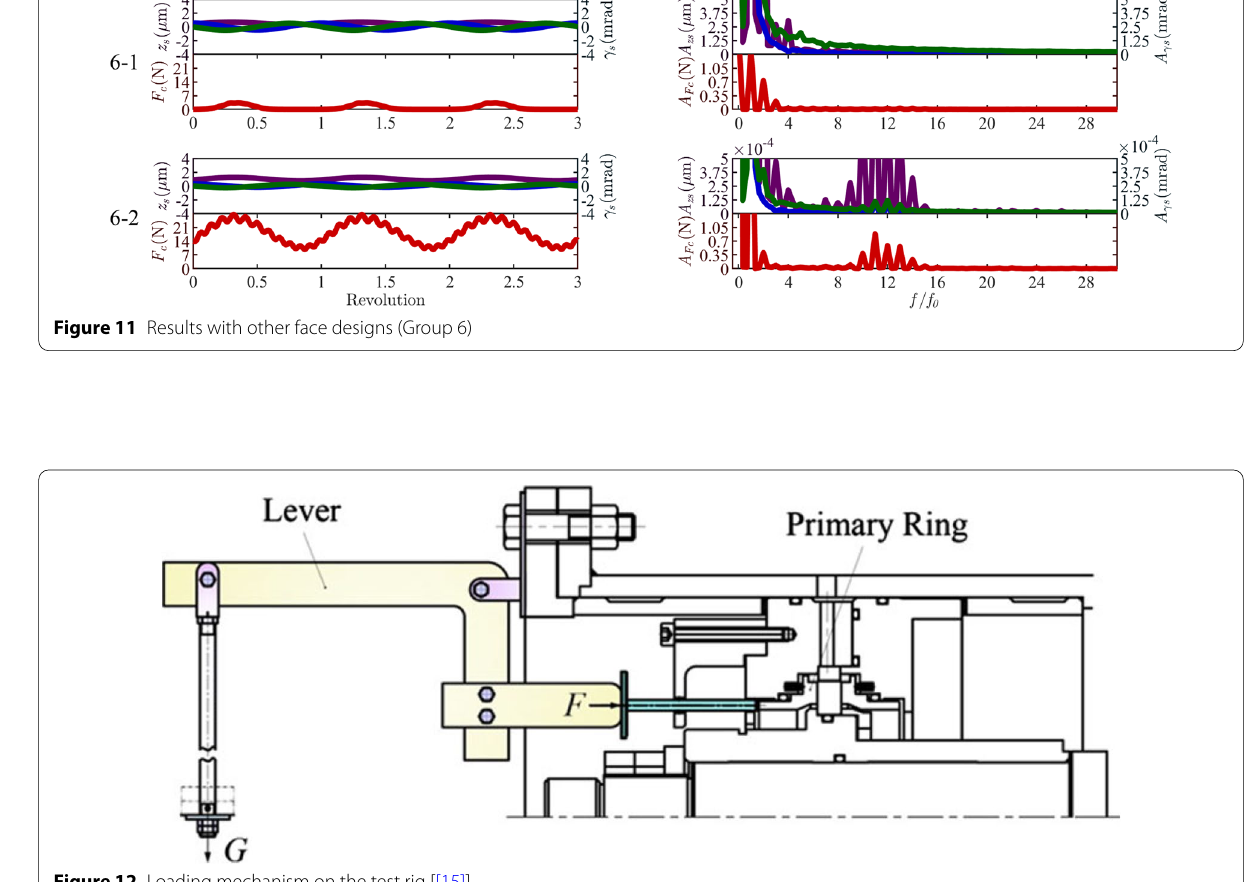
Figure 12 Loading mechanism on the test rig